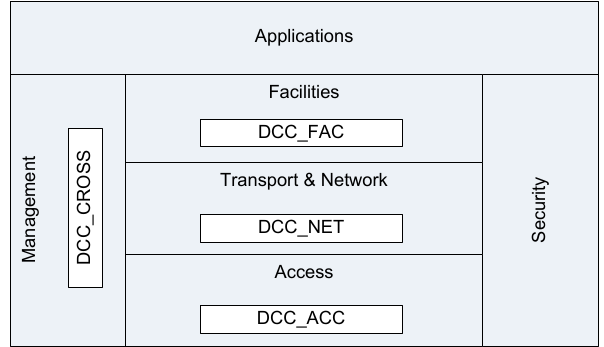
Figure 1. Decentralized Congestion Control (DCC) in the ETSI ITS Communications architecture [6].